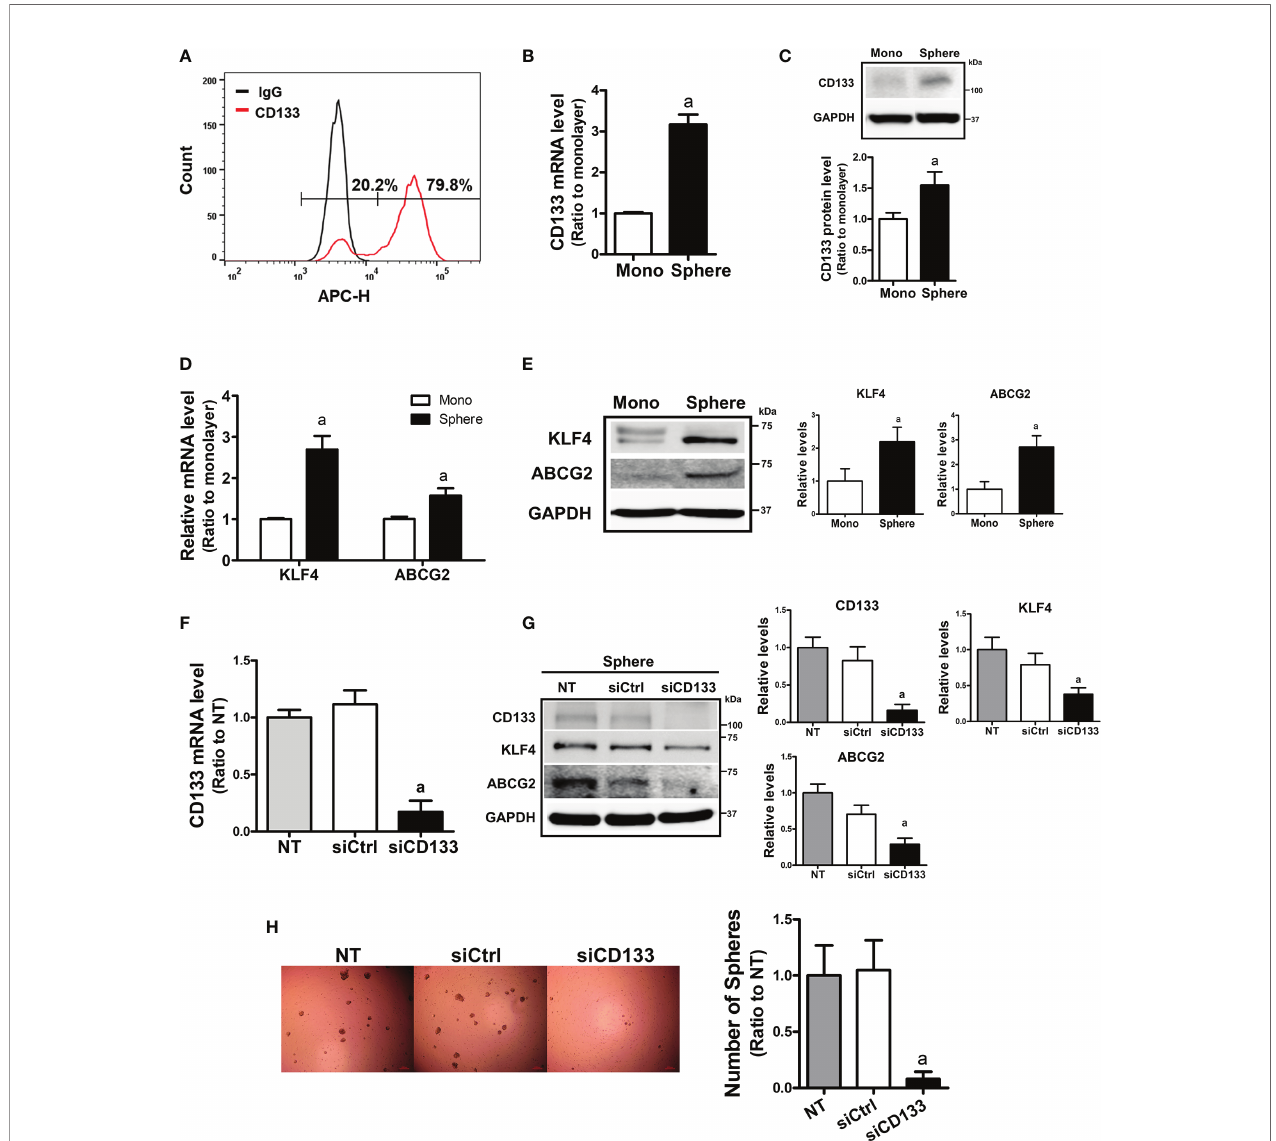
FIGURE 1 | Enhanced CD133 levels in sphere cultured HCT116 cells and their involvement in sphere formation. (A) The presence of CD133-positive cell population in monolayer-cultured HCT116 cells was analyzed using allophycocyanin (APC)- fl uorescence-based fl uorescence-activated cell sorting method. (B, C) Transcript (B) and protein levels (C) of CD133 were assessed in monolayer and sphere cultured HCT116 cells using relative quantitative reverse transcription-polymerase chain reaction (qRT-PCR) analysis and western blotting. Bar graph represents quanti fi ed protein levels from at least three experiments. a P < 0.05 compared with the monolayer HCT116. (D, E) The transcript (D) and protein levels (E) of Kruppel-like factor 4 (KLF4) and ATP-binding cassette subfamily G member 2 (ABCG2) in monolayer and sphere HCT116 cells were assessed. Bar graph represents quanti fi ed protein levels from at least three experiments. a P < 0.05 compared with the monolayer HCT116 cells. (F) Transcript levels of CD133 in the non-transfected (NT), non-speci fi c small interfering RNA (siRNA) (siCtrl)- or CD133-speci fi c siRNA (siCD133)- transfected HCT116 cells. a P < 0.05 compared with the siCtrl group. (G) HCT116 cell with either the non-speci fi c siRNA (siCtrl) or CD133-speci fi c siRNA (siCD133) transfection, were grown in sphere culture systems and the protein levels of CD133, KLF4, ABCG2 were examined. Bar graph represents quanti fi ed protein levels from at least three experiments. (H) Sphere formation was assessed in the non-transfected (NT), non-speci fi c siRNA (siCtrl)- or CD133-speci fi c siRNA (siCD133)- transfected HCT116 cells. Number of spheres over 70 m m diameter was counted using an image processing ToupView software. a P < 0.05 compared with the siCtrl group. Quanti fi cation results of western blotting were relative values to the loading control GAPDH. All values represent the mean ± standard error of the mean (SEM) of more than three